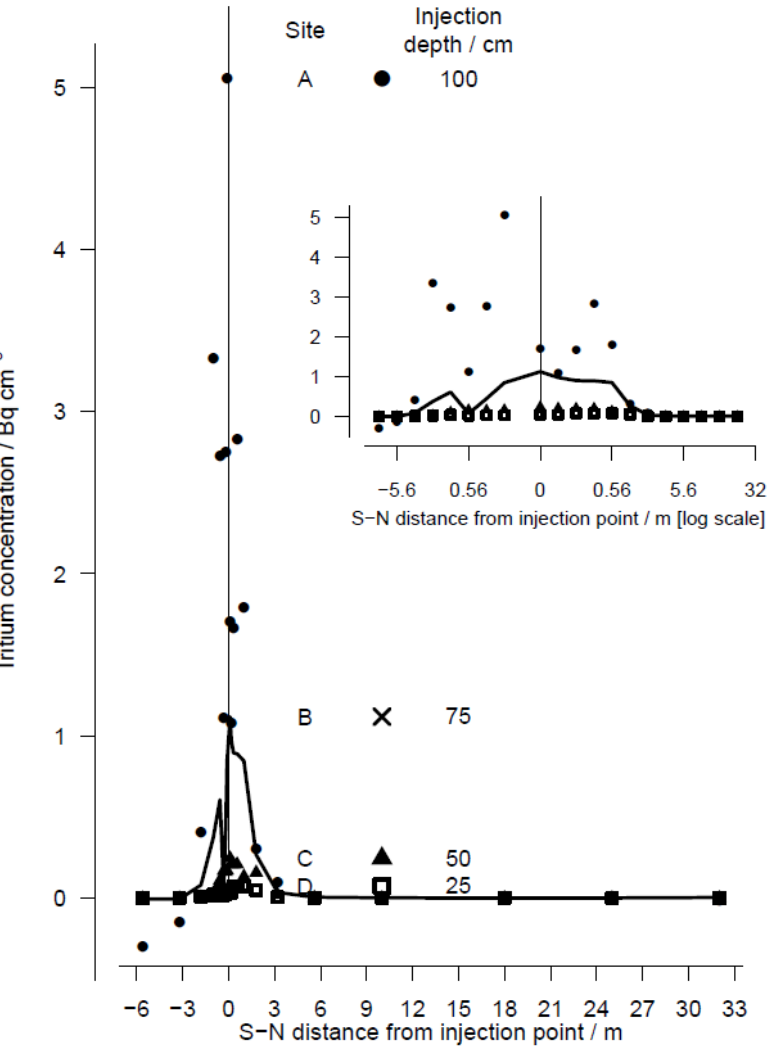
Figure 9. Mean concentration of tritium in pore water in whole core (peat and clay, if present) along a transect through the injection sites from S to N. Negative distances are along the ‘level’ towards the south; positive distances down the slope towards the north. The large symbols (repeating the small ones but shifted to the right) identify the sites and the depth of the tritiated water injection 24 years before sampling. Results for site ‘B’ are joined by lines. Symbols as in Figure 8. Inset: the same data and symbols plotted on a log- scaled distance axis, to show detail near the injection